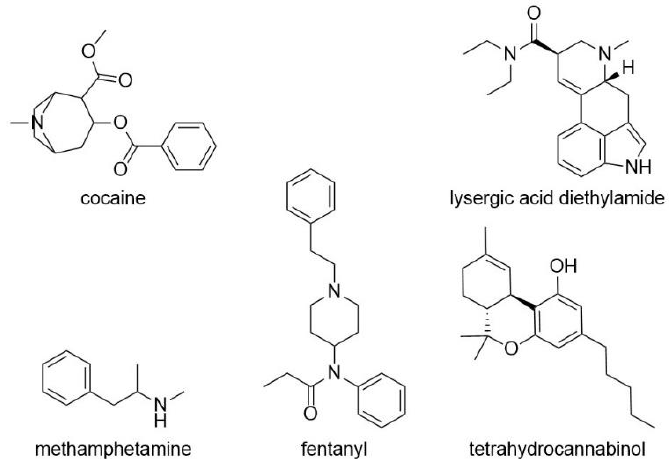
Figure 11. Common drugs structures that are discussed regarding hydrogels for sensing in this section.